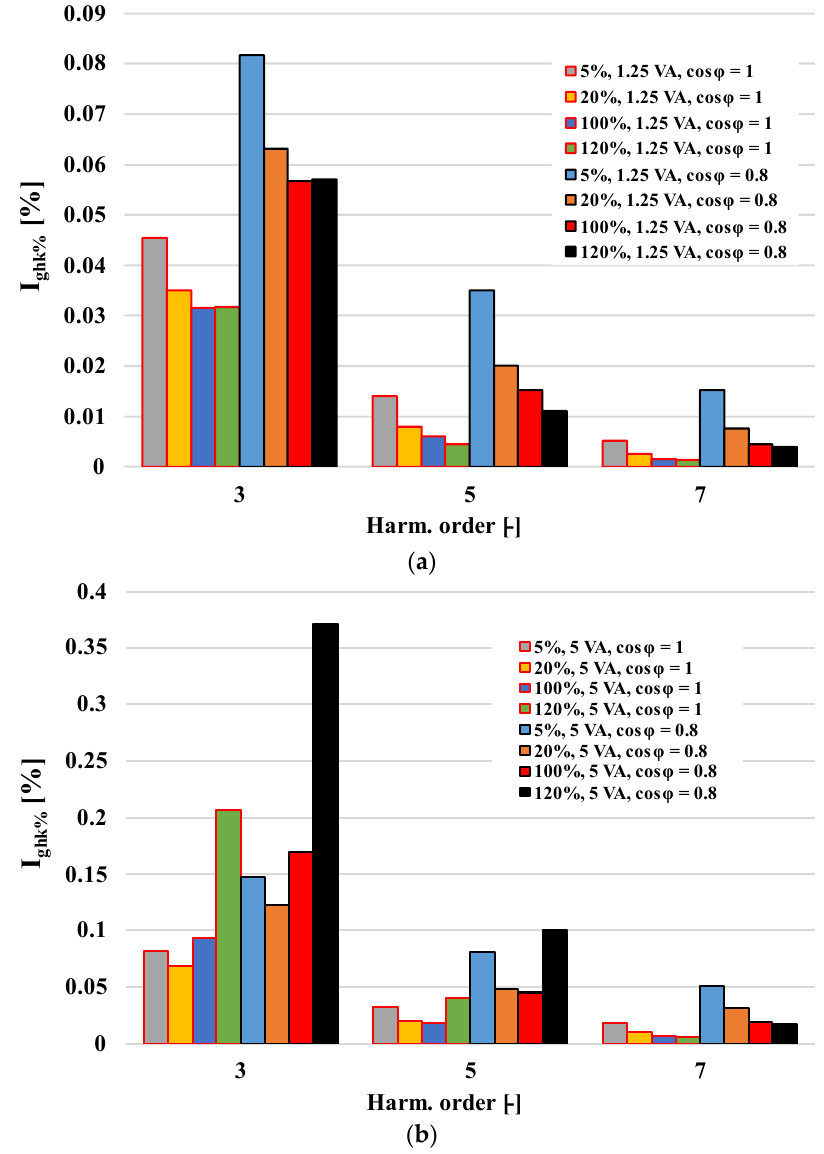
Figure 6. The levels of the generated harmonics in the secondary current by the inductive CT determined for 25% of the rated load ( a ) and for a rated load ( b ) with the power factors 0.8 inductive and 1.0. The percentages of generated higher harmonics in the secondary current by the tested inductive CT increased as the load increased. This was due to the shift of the work- ing position of the inductive CT on the magnetisation curve closer to the saturation region.